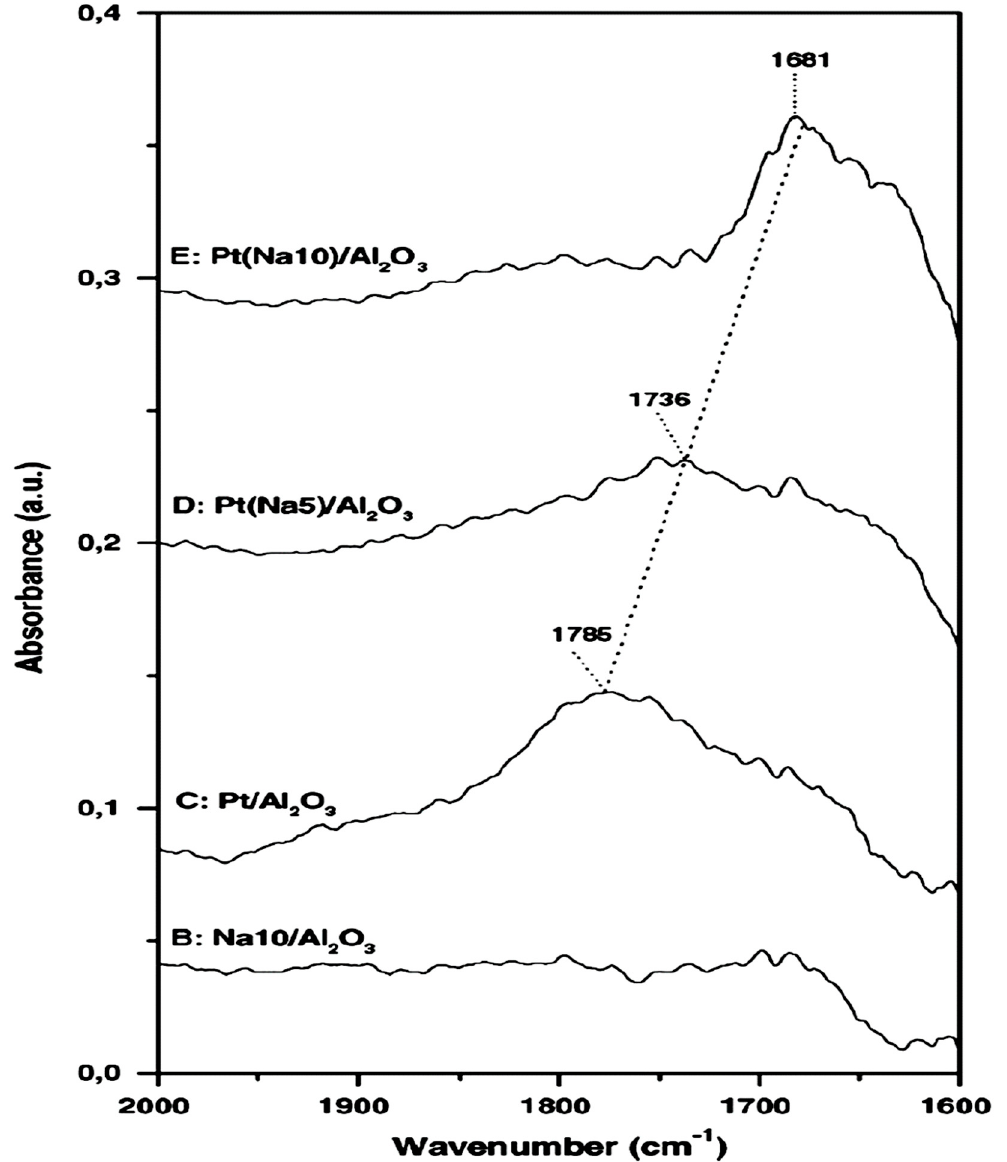
Figure 22. DRIFT spectra (expanded scale for the region 2000–1600 cm − 1 and subtracting spectrum of pure Al 2 O 3 ) obtained with 10wt%Na/ γ -Al 2 O 3 ( B ), Pt/ γ -Al 2 O 3 ( C ), Pt(Na5)/ γ -Al 2 O 3 ( D ) and Pt(Na10)/ γ -Al 2 O 3 ( E ) samples after NO adsorption for 1 min at 27 °C. (Reprinted with permission from Ref. [113]; Copyright 2007, Elsevier).